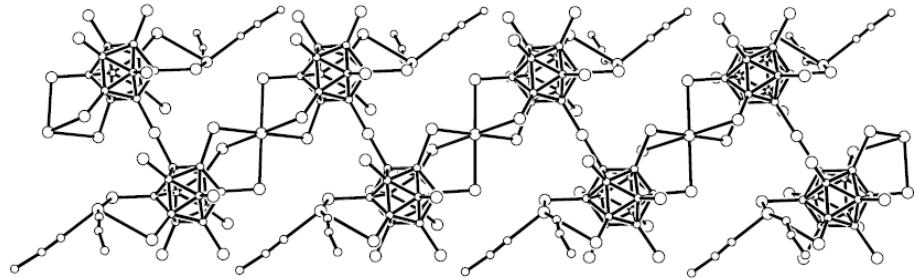
Figure 97. Fragment of X-ray structure of {((MeCN) 4 Ag 3 )(Ag[HCB 11 I 5 Br 6 ] 2 )·2(MeCN)} n . Reproduced with permission from reference [107]. Copyright © (2003) John Wiley & Sons.